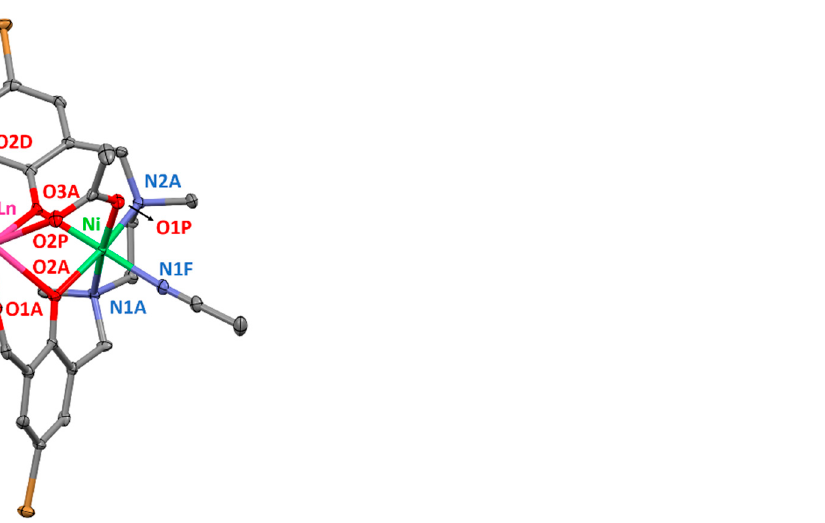
Figure 2. Perspective view of the molecular structure of 5 . Crystallization solvent molecules and hydrogen atoms are omitted for clarity. Colour code: N = blue, O = red, C = grey, Br = brown, Ni = green, Ln = pink.